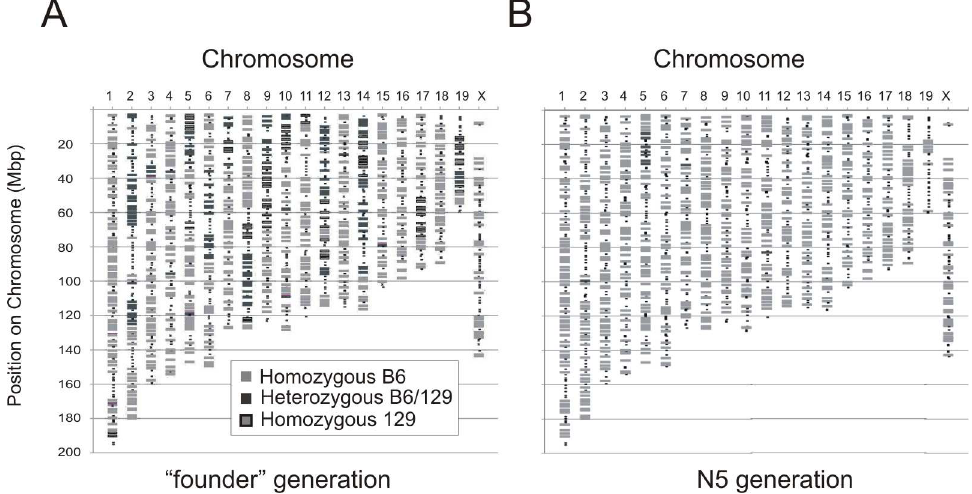
Fig 1. Evaluation of the genetic background of Rint1 +/- mice. Genome-wide SNP genotypingof the four founder Rint1 tm1WHL mice, each of which was heterozygous for the Rint1 knockout allele, was performed. A representative exampleis shown (A) revealinga highly mixed 129 x B6 geneticbackground. After marker assisted selectionusing simple sequencerepeat markers, genome-wide SNP genotyping was again performed on a group of Rint1 +/- mice (N = 4). A representative exampleis shown (B) clearly demonstrating that 129 alleles unlinkedto the Rint1 knockout allelehave been